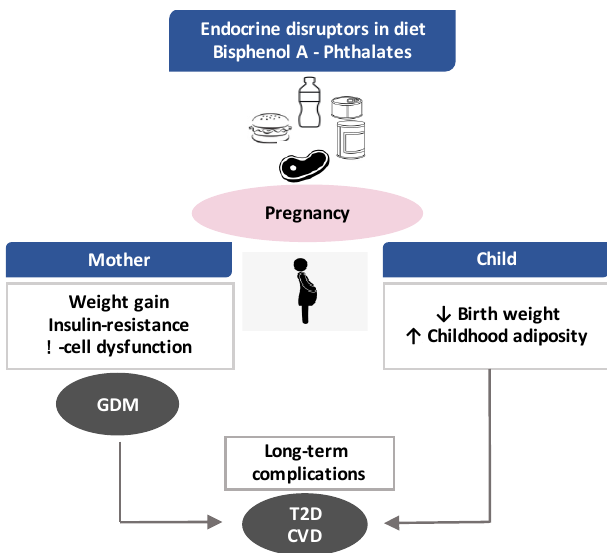
Figure 1. Endocrine disruptors in diet and pregnancy outcomes. GDM: gestational diabetes mellitus, T2D: type 2 diabetes and CVD: cardiovascular disease.